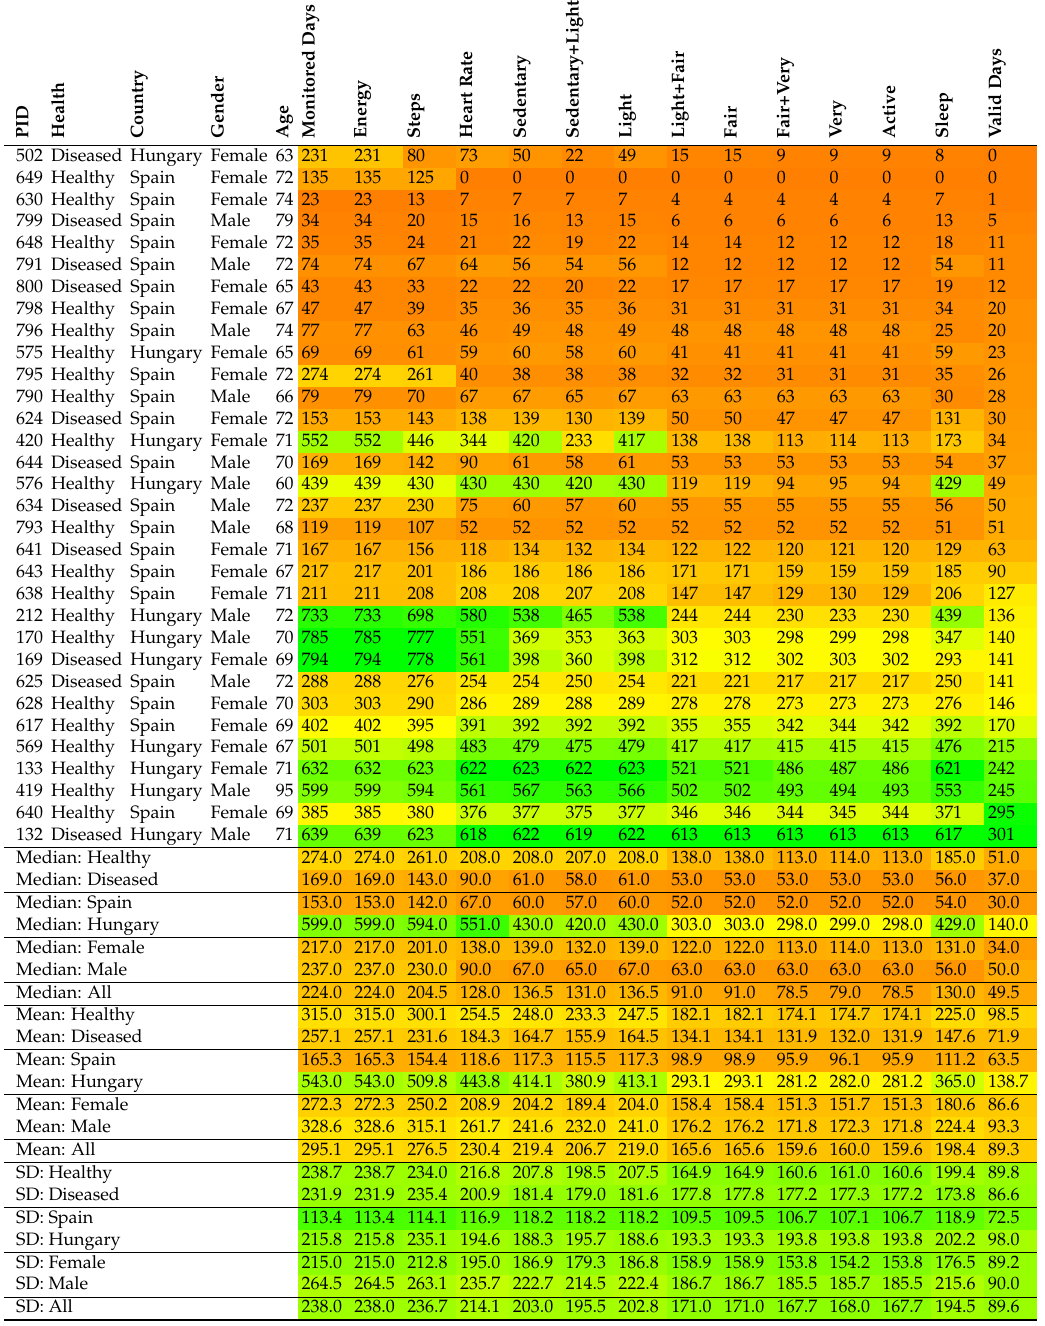
Color coding: from orange (fewer days relative to others) to yellow to green (more